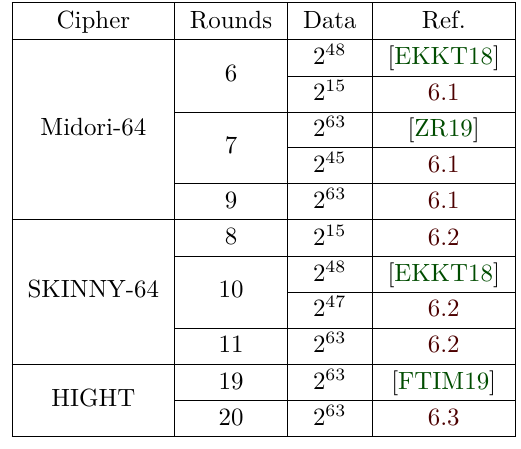
Table 1: Summary of the best integral distinguishers found by our tool. Note that in our case, a distinguisher against a cipher E means we found two linear mappings L and a distinguisher against L out ◦ E ◦ L in